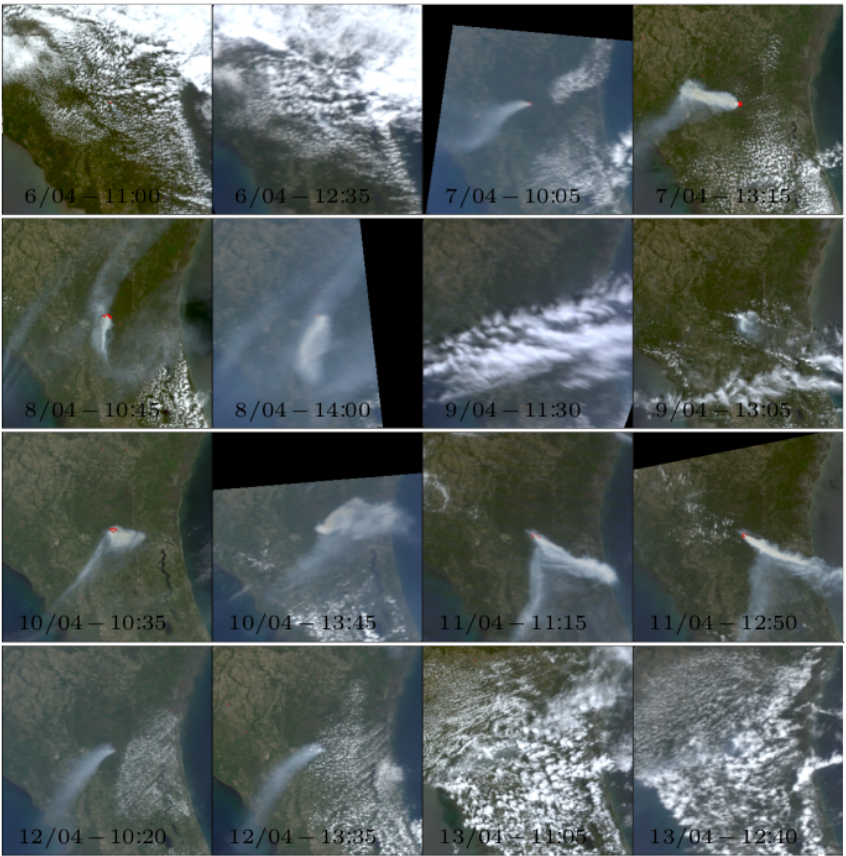
Figure 1. True colour composite of daytime observations of the county fire (USA), made from the Moderate Resolution Imaging Spectrora- diometer (MODIS) satellite EO sensor. The fire occurred in Ocala National Forest (Florida) between 5 and 13 April 2012. MODIS data from all available Terra and Aqua satellite overpasses are shown, with the local time indicated. Overlain on the colour composite imagery are red vectors that outline pixels detected as containing active fires by the MODIS MOD14/MYD14 Active Fire and Thermal Anomaly Products (Giglio et al., 2003). The regularly changing nature of the fire and the smoke transport apparent from this time series, as well as the presence on some days of bifurcated plumes, is very